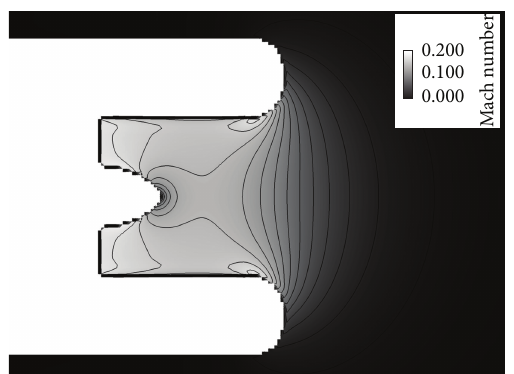
Figure 11: Mach number distribution around the JT15D